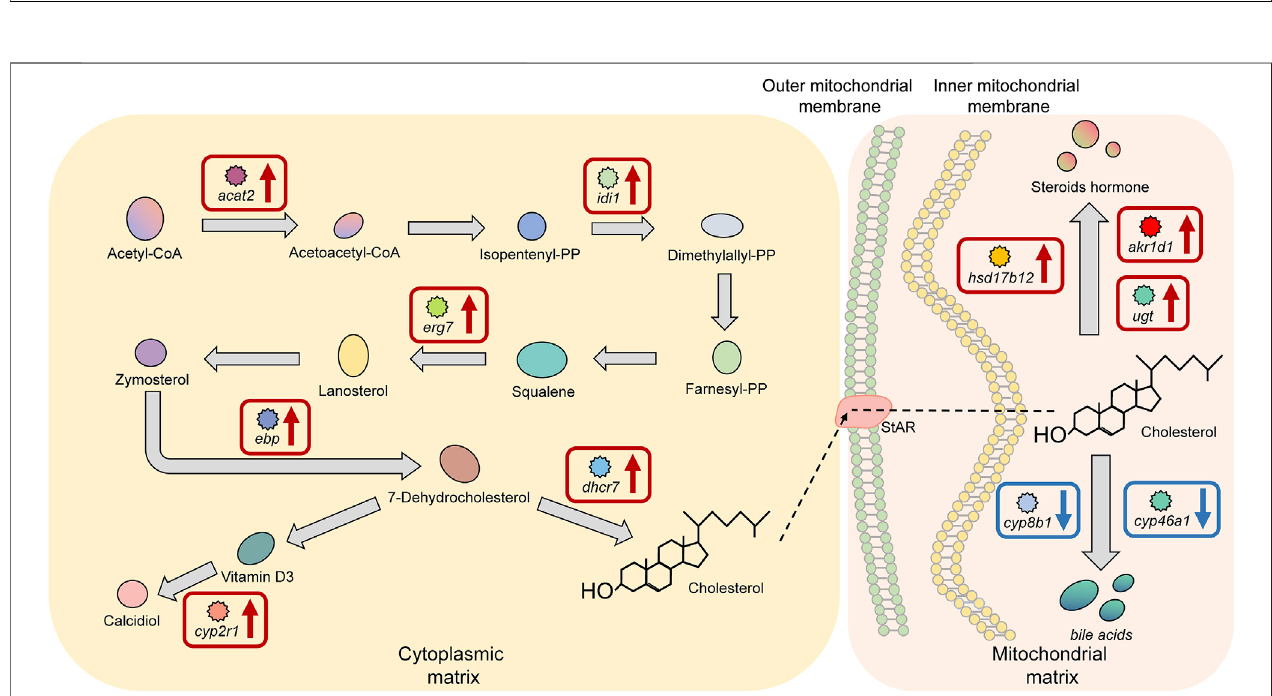
FIGURE8| Keyfactorsofthe “ cholesterolbiosynthesisandmetabolismpathway ” insuperiorgrowthperformanceNiletilapia.Redboxesmarkupregulatedgenes, and blue boxes mark downregulated genes. Genes encoding key enzymes involved in synthesis of bile acids from cholesterol ( cyp8b1 , cyp46a1 ) were downregulated, and genes encoding key enzymes involved in synthesis of steroid hormones from cholesterol ( hsd17b12 , akr1d1 , ugt ) were upregulated.